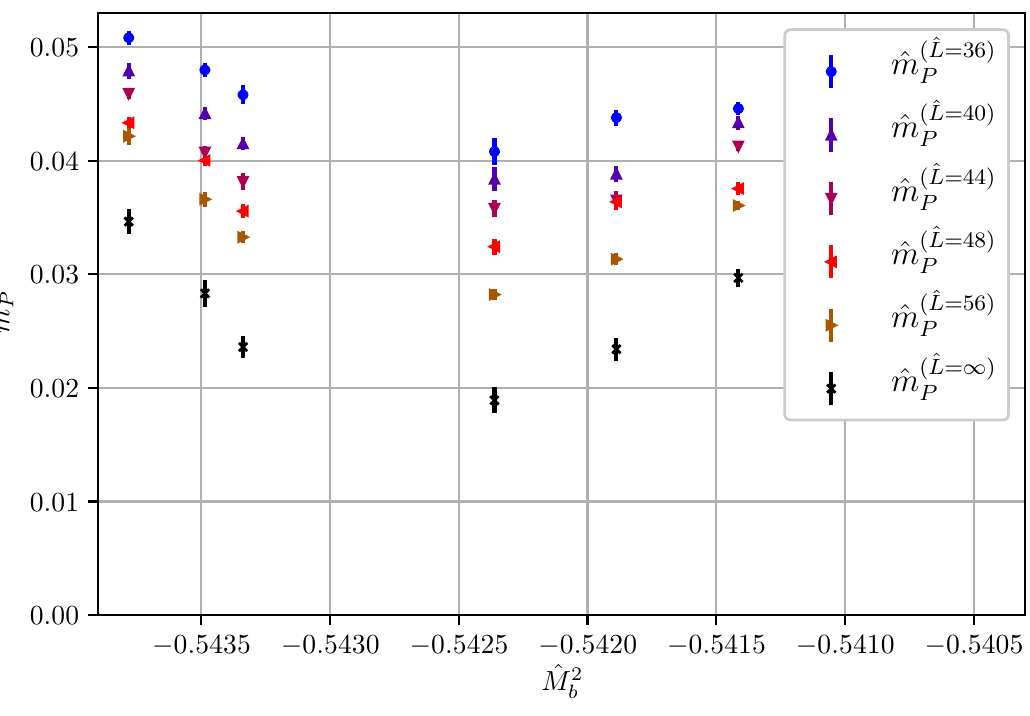
Figure 3 . The in(cid:12)nite volume extrapolations of the pole mass m